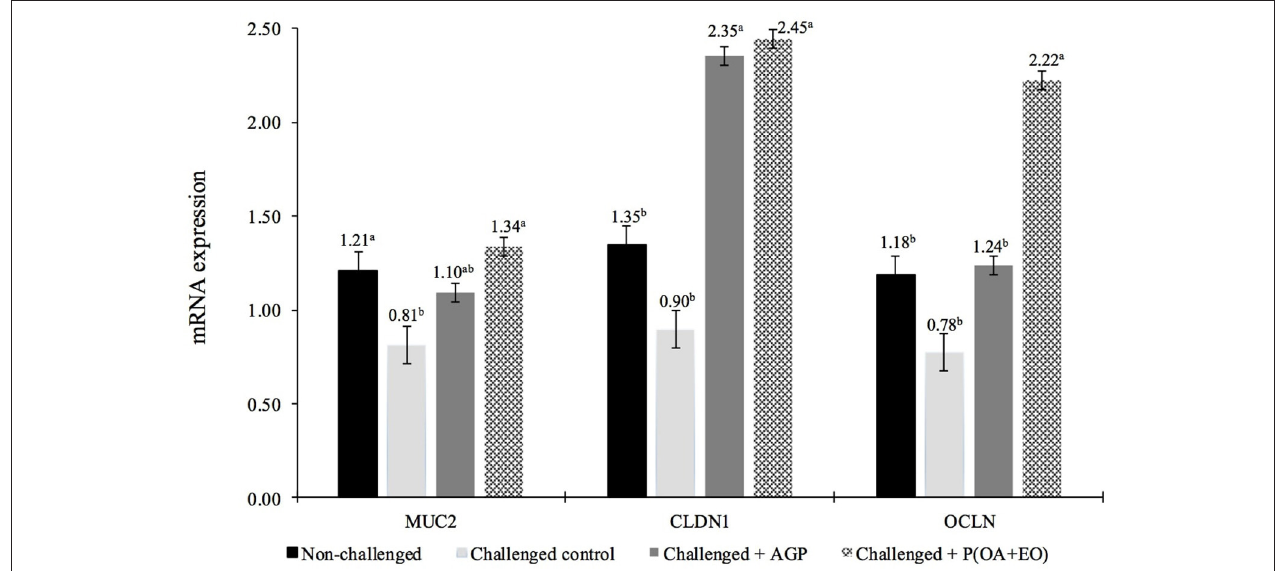
FIGURE 1 | Jejunal gene expression responses at 21 days of broiler chickens undergoing an intestinal challenge and fed diets supplemented or not with an antibiotic growth promoter (AGP) or a protected blend of organic acids and essential oils [P(OA + EO)]. Mucosa samples were taken from one bird per pen ( n = 60). Evaluated genes were mucin2 (MUC2), claudin1 (CLDN1), and occludin (OCLN). All values are in arbitrary units (bars indicate the SEM; a,b P < 0.05 for MUC2 and a,b P < 0.001 for CLDN1 and OCLN; Fisher LSD).